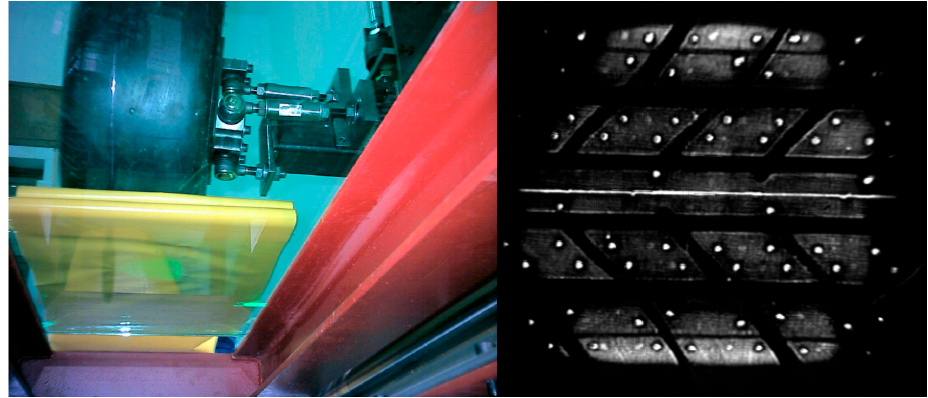
Figure 2. Test bench bottom view ( left ); and example of image obtained with the test bench ( right ).